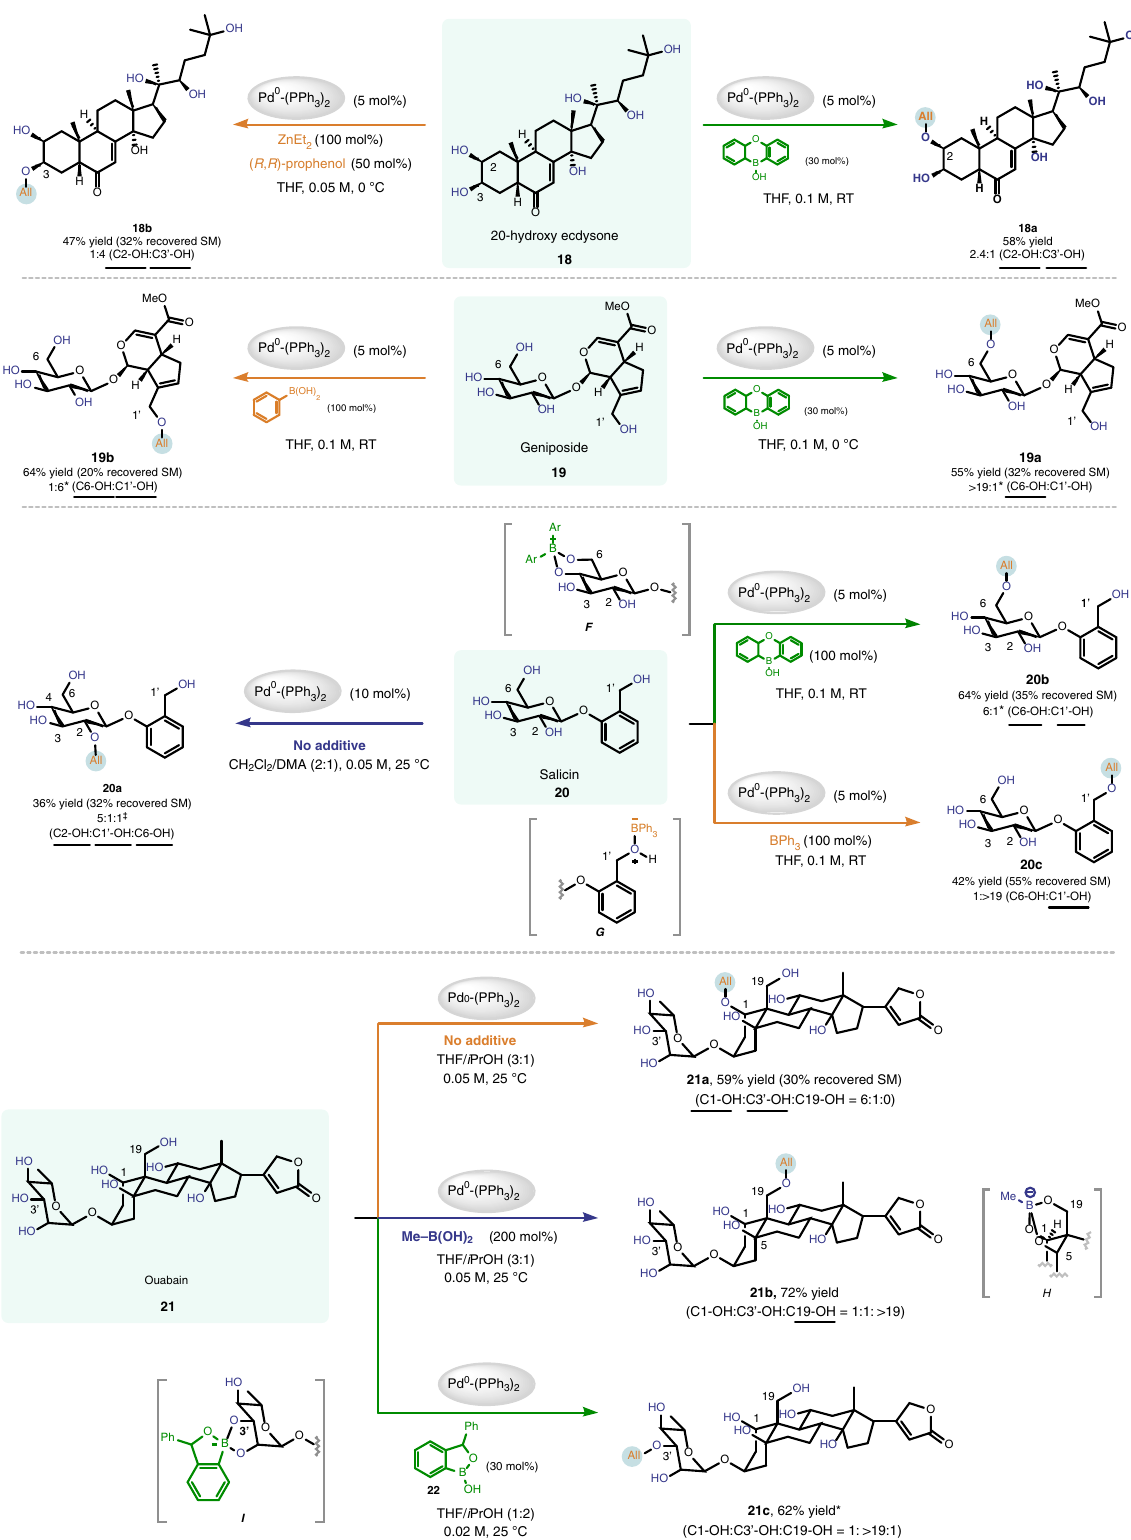
Fig. 5 Site-switchable mono- O -allylation of polyhydroxylated natural products. Product ratios were determined by 1 H NMR analysis of crude reaction mixtures. Reported yields are isolated yields of products that are underlined. * A small amount of diallylated product was also formed. ‡ Small amounts of C3-OH and C4-OH modi fi ed products were also formed. DMA, N,N -dimethyl acetamide. See Supplementary Information for experimental